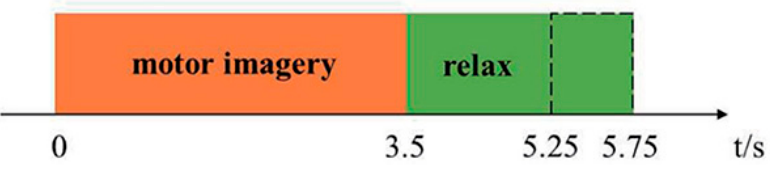
Figure 1. EEG signal recording versus time in